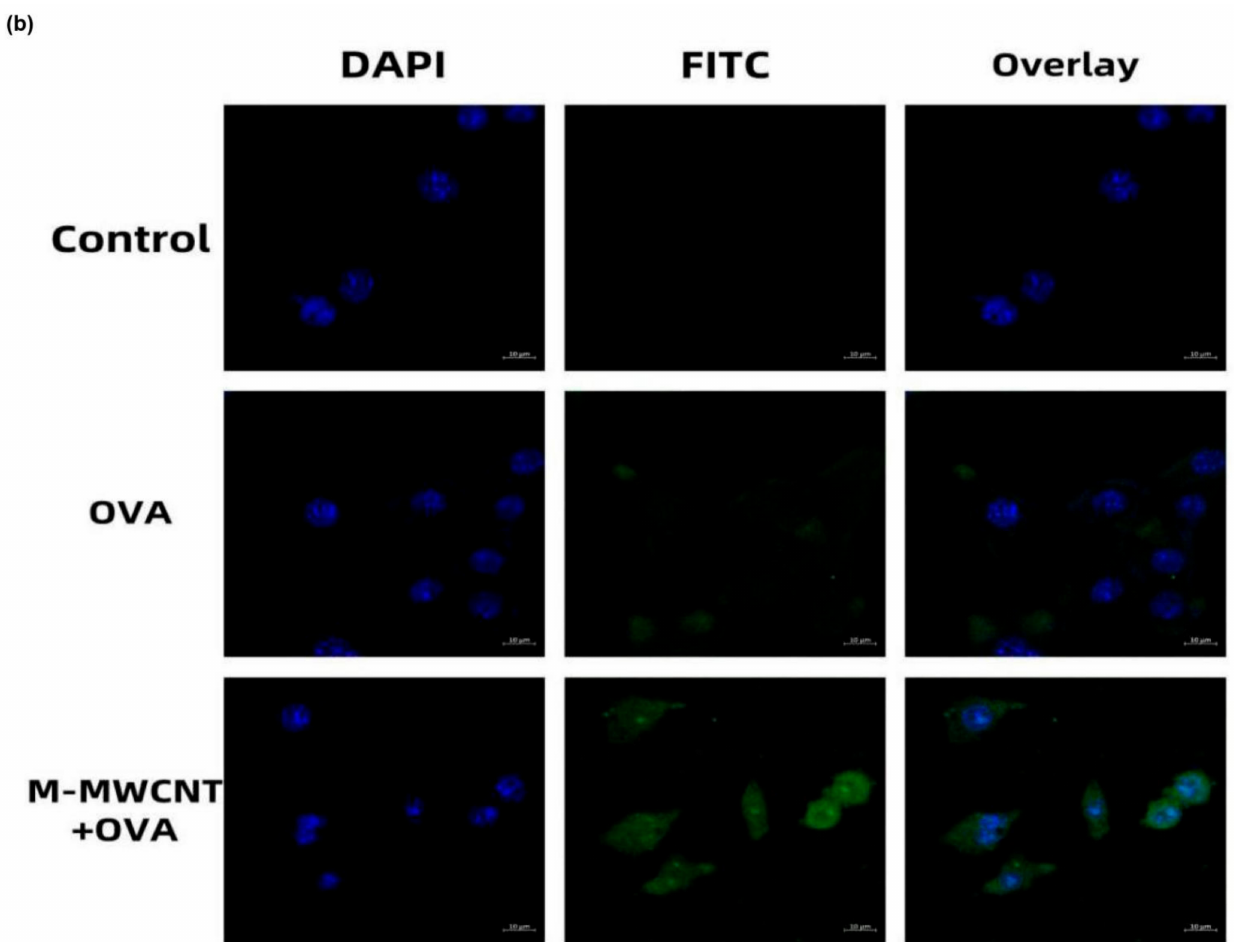
Figure 6. CLSM and TEM image of M-MWCNT uptake by RAW267.4. ( a ) TEM micrographs of M-MWCNT (indicated by arrow) internalized by macrophages. M-MWCNT was co-cultured with macrophages for 12 h and then the collected cells were immediately fixed with 2.5% glutaralde- hyde. The fixed cells were sectioned and observed by TEM. ( b ) CLSM image of FITC-OVA uptake by RAW267.4. Macrophages were cultured with M-MWCNT+FITC-OVA or FITC-OVA for 24 h. The slides were fixed and stained with DAPI as indicated by blue fluorescence, while green flu- orescence indicates FITC-OVA. The cells were observed and photographed with a laser confocal scanning